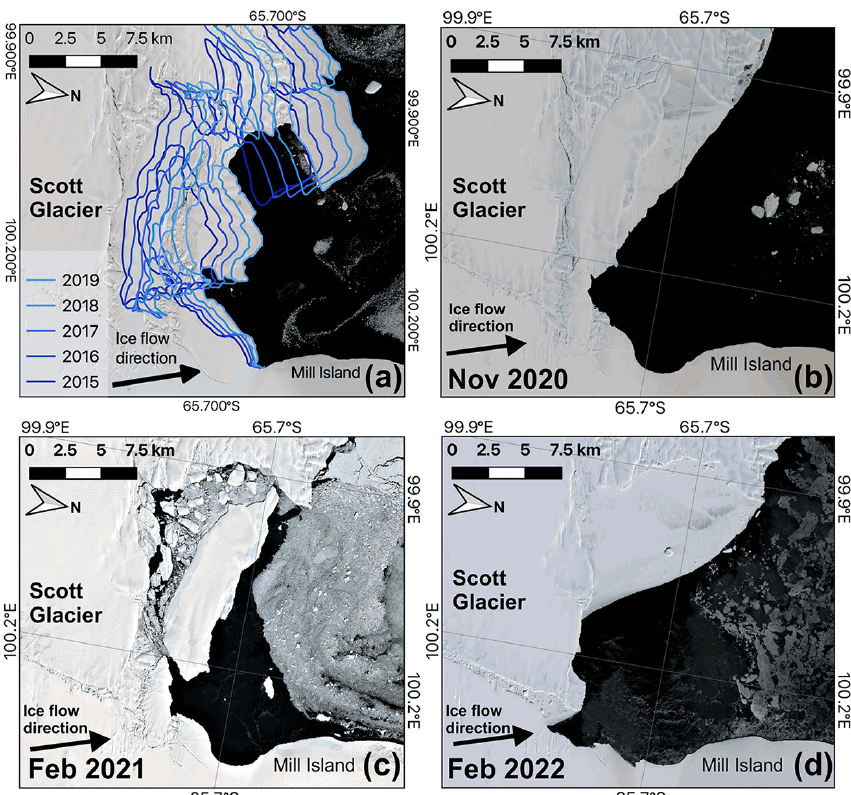
Figure 3. (a) Scott Glacier ice front position between 2015 and 2019 mapped from Landsat 8 OLI acquired on 16 February 2019, 1 Febru- ary 2018, 24 February 2016 and 7 February 2015 and from Sentinel 2A acquired on 23 February 2017 (background: Landsat 8 OLI – 16 February 2019). (b) Scott Glacier ice front on 26 November 2020, the central portion of the front has lost some of the blocks held in place by fast ice and an area immediately to the south of Mill Island (Landsat 8 OLI). (c) Scott Glacier ice front on 27 February 2021, the fast ice has broken up, and a larger block is separated (Sentinel 2B). (d) Scott Glacier ice front on 21 February 2022 (Sentinel